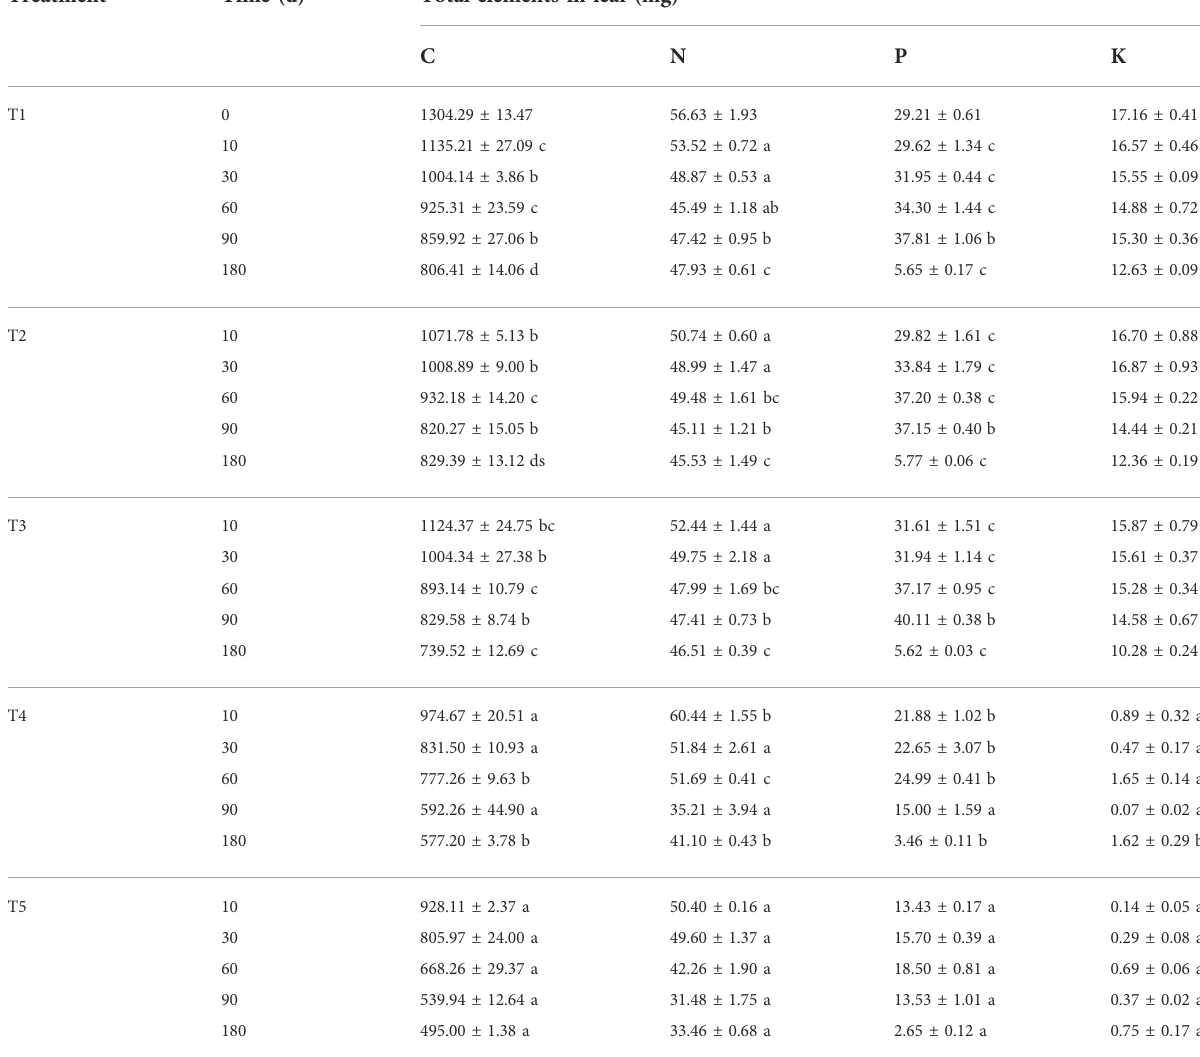
TABLE 3 The total amount of each element in the leaves of pond cypress trees in the Three Gorges Reservoir, China. Treatment